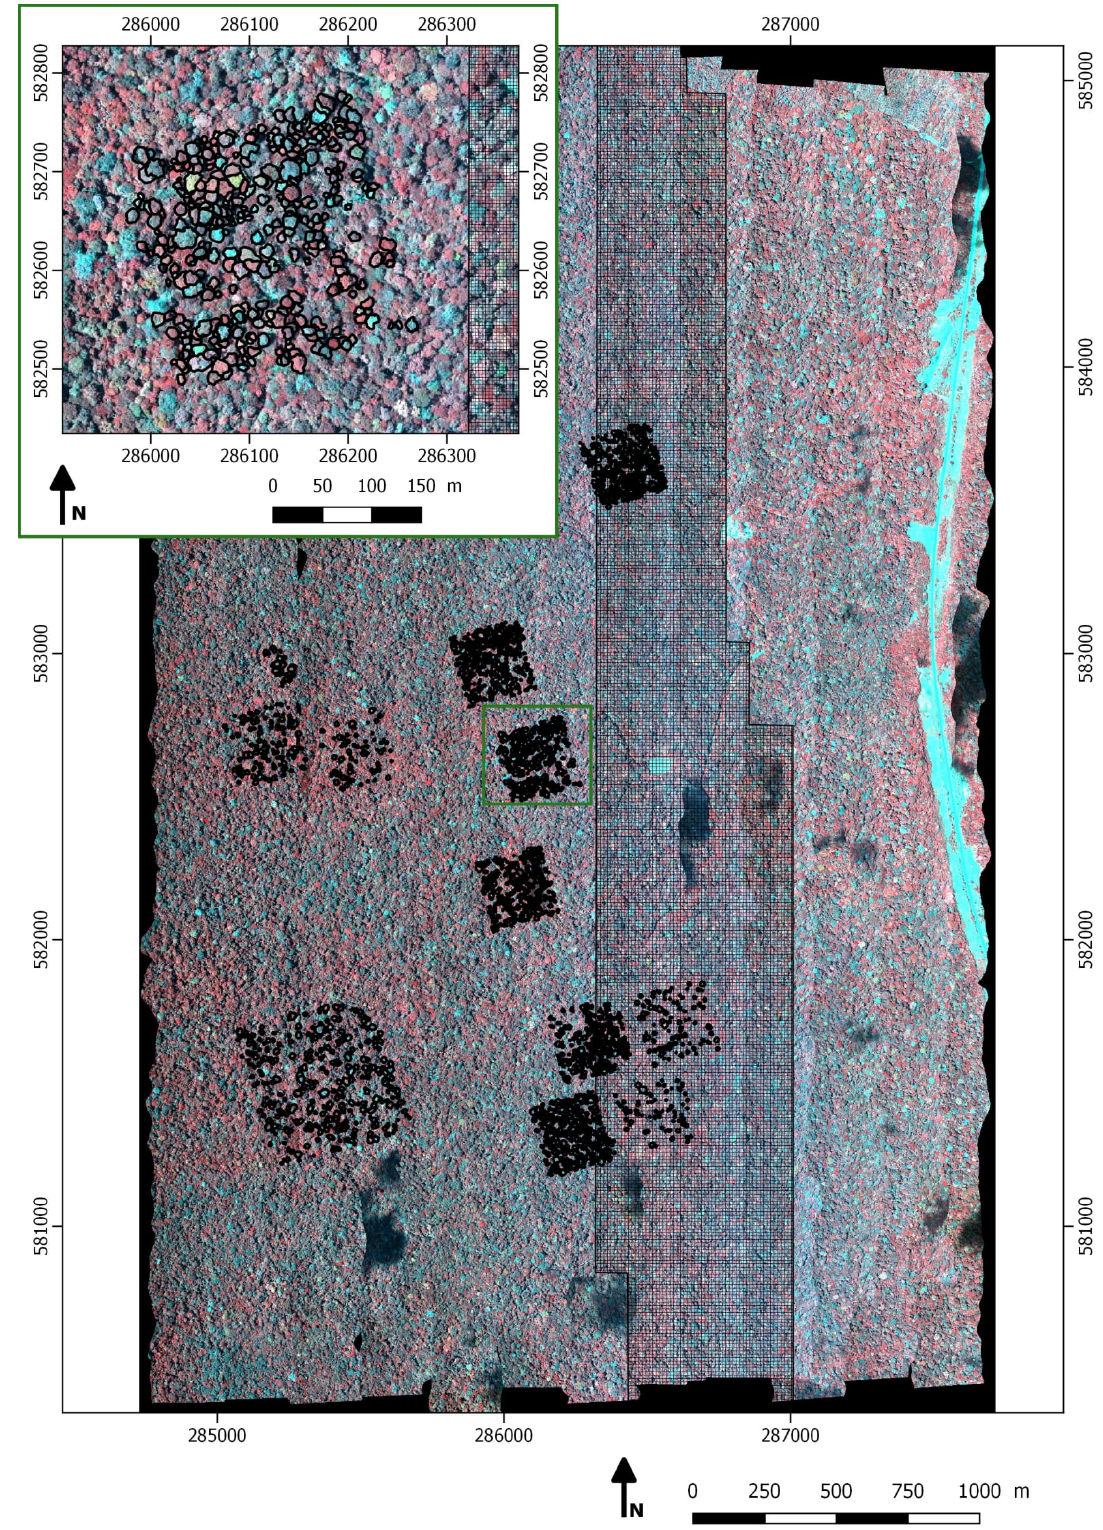
Figure 1. Hyperspectral image (false colour, R: 775 nm, G: 637 nm, B: 426 nm) at sensor radiance, captured on 19 September. Black segments feature the tree crowns used in this study. The grid pattern in black represents the area imaged on 20 September. In the zoomed map (green box), crown segments are delineated in black too. Projection used is WGS 84 UTM 22N (EPSG: